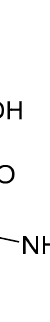
Figure 13. The chemical structure of GSK-070, an oxoborate drug in TB clinical trials. The efficacy of GSK-070 was assessed against replicating and nonreplicating/slow- replicating mycobacteria in mice models of acute and chronic Mtb H37Rv lung infections [273,274]. In the acute model, a maximum difference of 3.6 log 10 CFU was obtained in the lungs compared to untreated mice for 8 days; whereas the chronic cohort produced a drop of 2.1 log 10 CFU after 2 months of daily oral treatment at maximum doses of 1.1 and 1.3 mg/kg, respectively [273]. A recent phase 1 clinical study evaluating the safety, tolerabil- ity, and pharmacokinetics of single and repeat oral doses of GSK-070 met all primary end- points and showed no serious adverse events [179,275]. The study determined potent in-